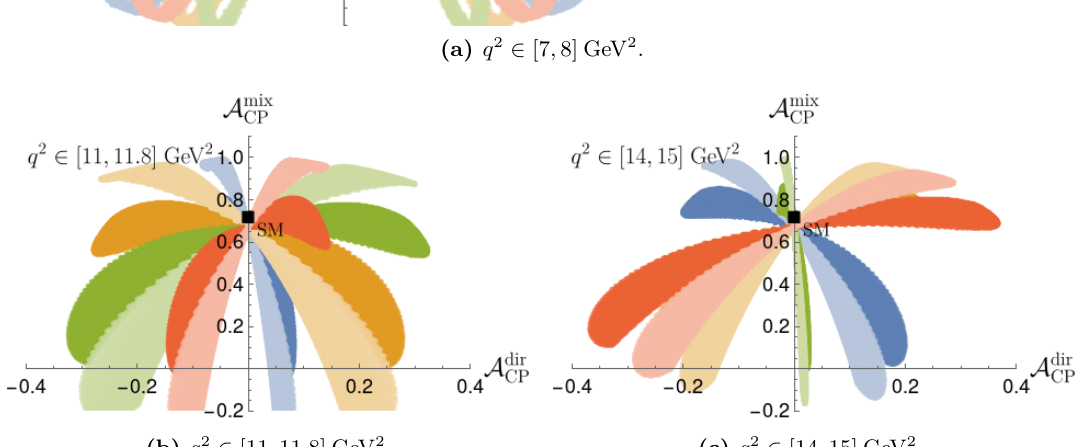
and A mix in different q 2 bins including all four hadronic CP CP